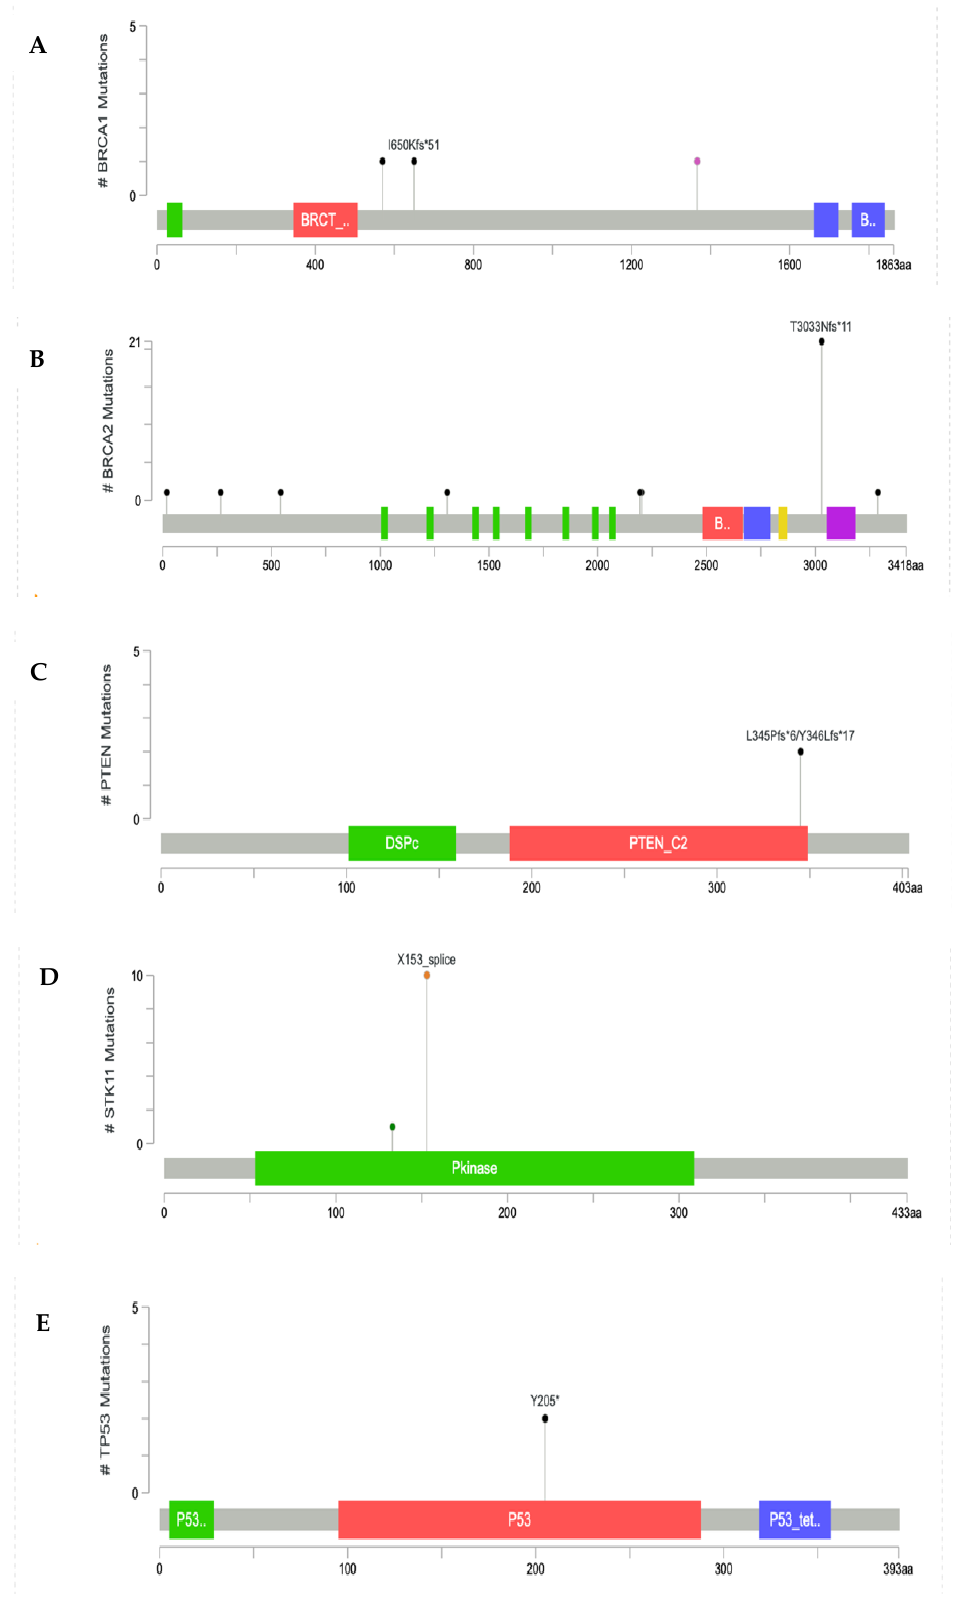
Figure 2. Distribution of genes in: ( A ) single P/LP-Vs carriers, ( B ) multiple P/LP-Vs carriers. The positions of the pathogenic variants for high-penetrance genes, such as BRCA1, BRCA2, PTEN, STK11, and TP53, were visualized in Lollipop plot, as shown in Figure 3. Most of the P/LP-Vs had not been recorded yet in the dbSNP or CinVar databases, and were designated as novel variants with their clinical significance predicted by VarSome.